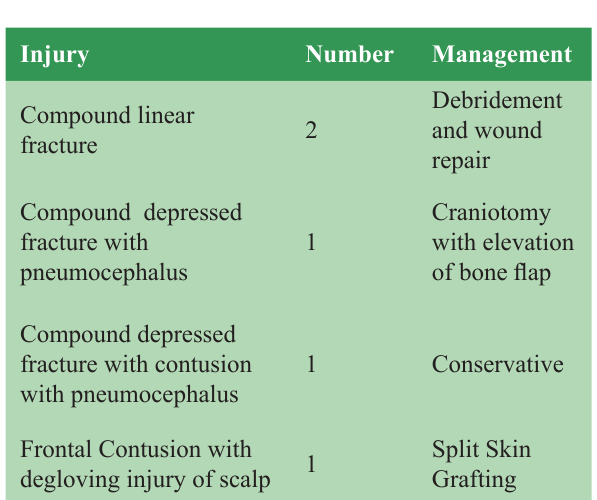
Table 1: Types of injury